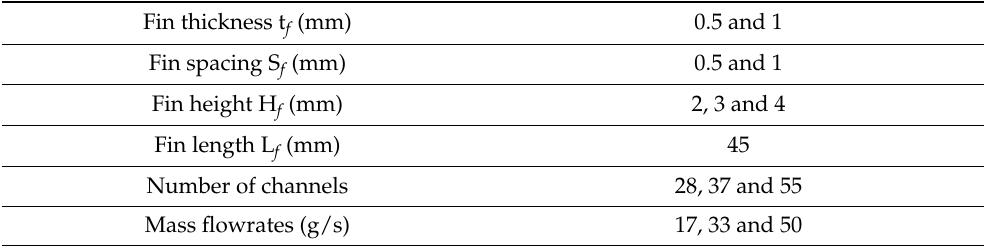
Table 1. Specifications of the case